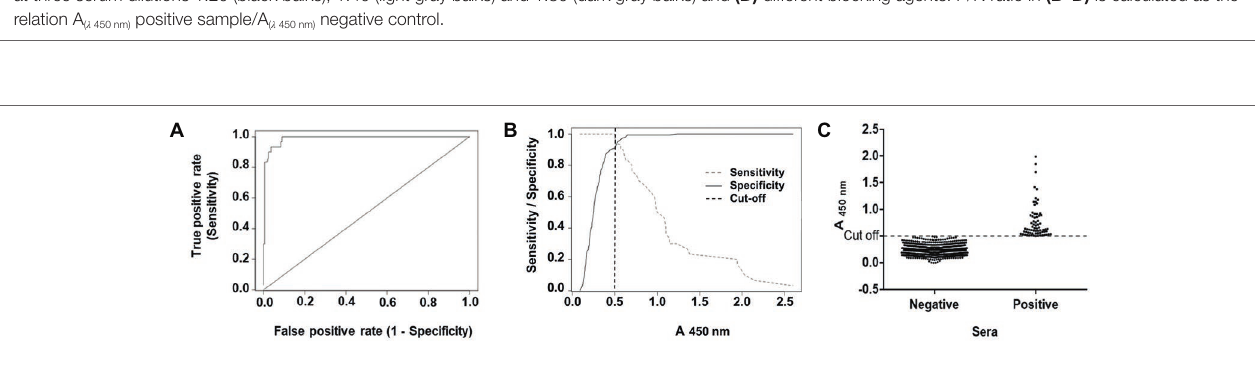
TABLE 1 | Performance of the in-house ELISA compared to the commercial ELISA (DIA.PRO) in detecting anti-HEV IgG.